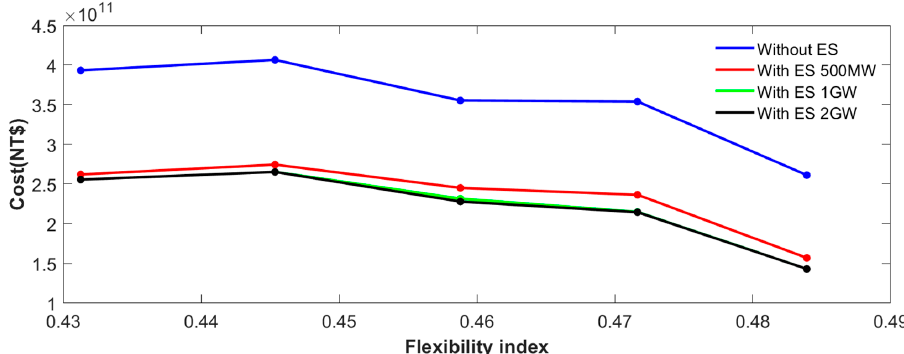
Figure 11. Relationship between multi-scenario unit-scheduling cost and generation flexibility in summer.